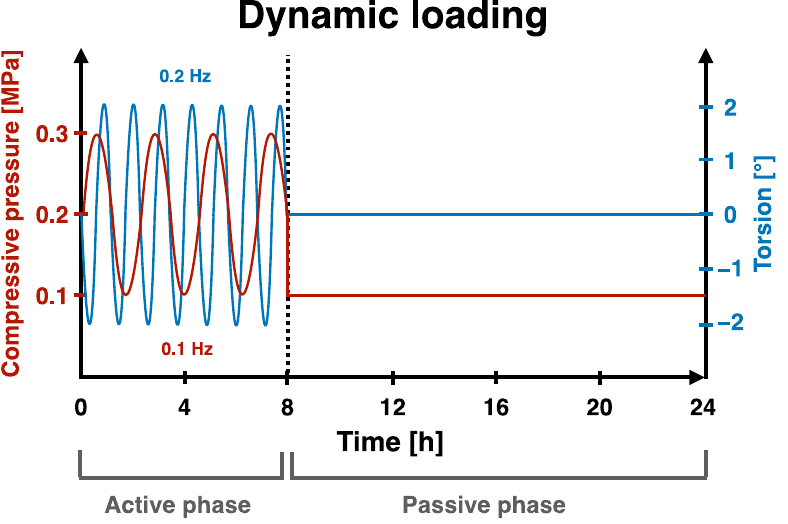
Figure 2. Representation of the daily dynamic loading regime, which was repeated for 14 days. The red line represents the compressive pressure, and the blue line represents the torsion.